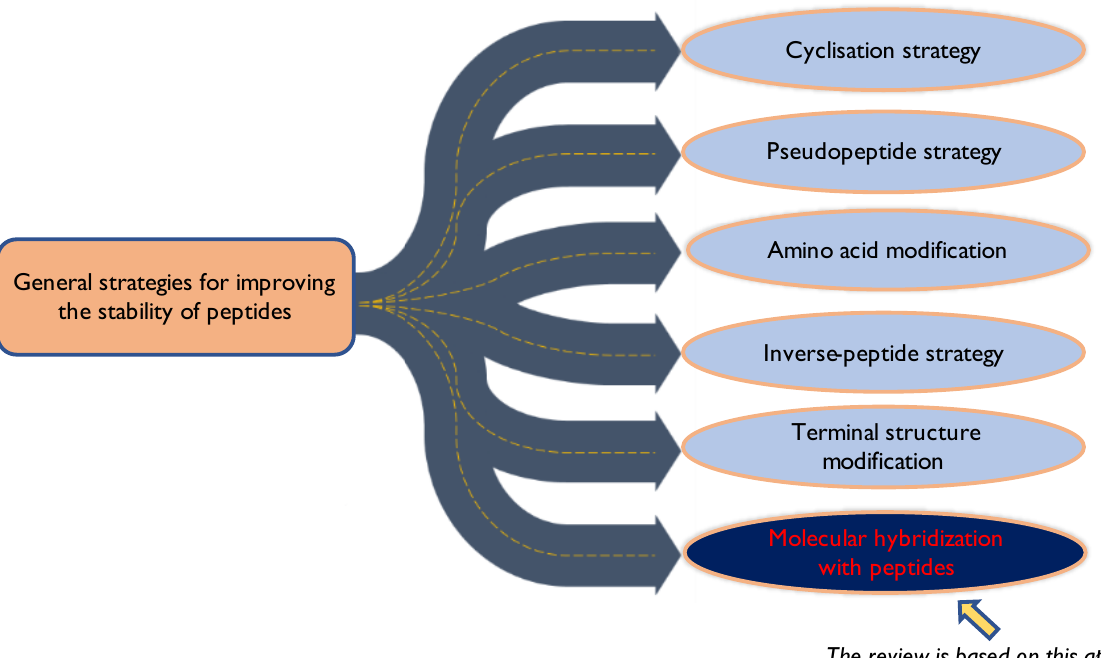
Figure 7. Different strategies used in peptidomimetics.